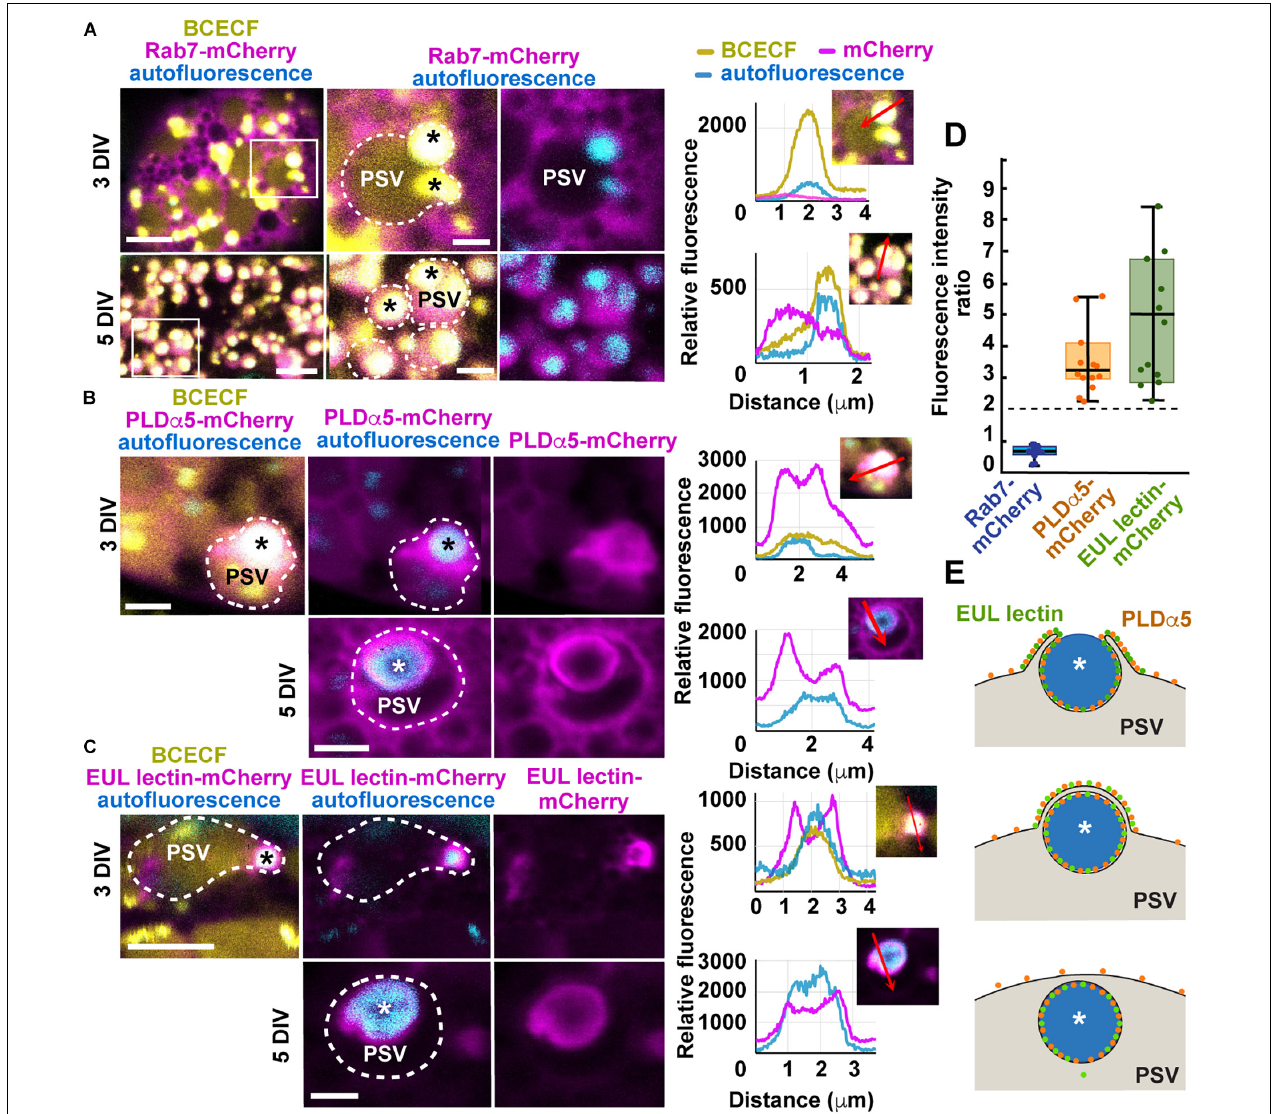
FIGURE 7 | Expression of mCherry translational fusions of Rab7, PLD α 5, and EUL-lectin protein in aleurone cells of in vitro -cultured endosperms transformed by biolistic bombardment. (A–C) Endosperms were collected at 8 DAP and placed on culture plates, bombarded 2 days later, and imaged between 24 h (8 DAP + 3 DIV) and 72 h after bombardment (8 DAP + 5 DIV). Protein storage vacuoles (PSVs) were detected by BCECF-AM staining and storage protein bodies (asterisks), by their intrinsic fluorescence. The outline of PSVs is indicated by dotted lines. (A) mRab7-mCherry shows a cytoplasmic distribution at 3 DIV but it is almost completely internalized into PSVs by 5 DIV. The areas highlighted by a white box in the panels on the left are shown at higher magnification in the middle and right panels. Fluorescence intensity profiles were calculated along the red arrows indicated in the selected panels. (B) PLD α 5-mCherry localizes to the tonoplast of PSVs and around partially or completely engulfed protein bodies, at 3 DIV and 5 DIV, respectively. (C) EUL lectin-mCherry localizes almost exclusively to the tonoplast domain surrounding partially or completely engulfed protein bodies. (D) Boxplot showing fold enrichments of PLD α 5-mCherry and EUL lectin-mCherry average fluorescence intensity around the storage protein inclusions compared to other areas on the PSV tonoplast. Only regions with no saturated pixels were measured ( n = 14 PSVs from PLD α 5-mCherry and 12 PSVs for EUL lectin-mCherry). The expected ratio (2) for proteins evenly distributed across the tonoplast is indicated by a dashed line. (E) Diagram showing the main steps in microautophagy of protein bodies in maize aleurone cells and the distribution of PLD α 5 and the EUL lectin during this process. Scale bars = 5 µ